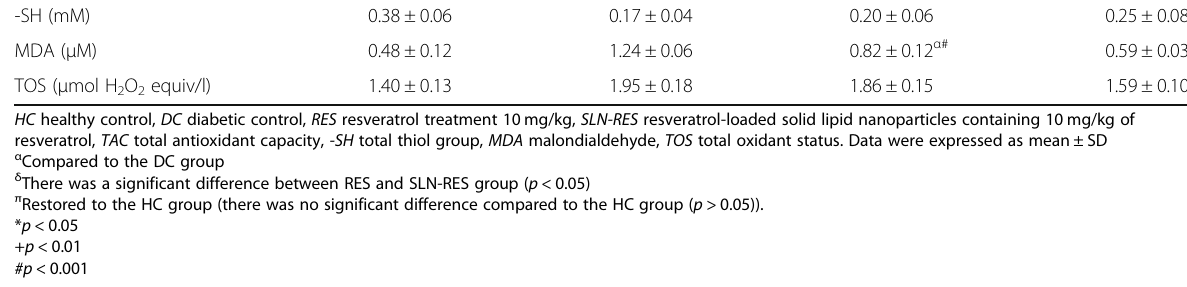
Table 3 The effect of RES and SLN-RES treatment on the oxidant and antioxidant indicators in diabetic rat models Groups